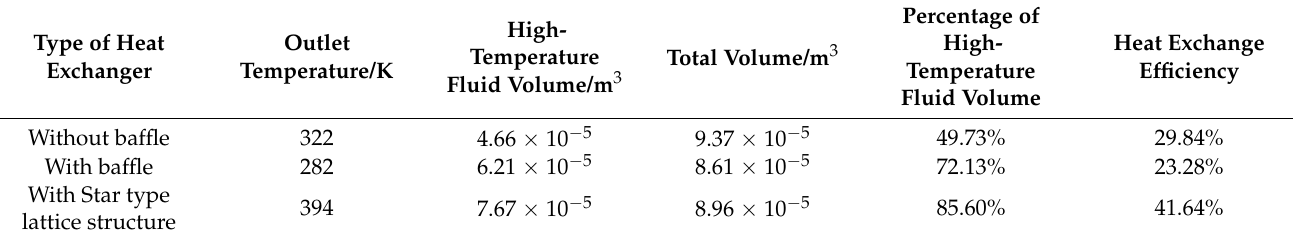
Table 1. Statistics on the proportion of outlet temperature and heating